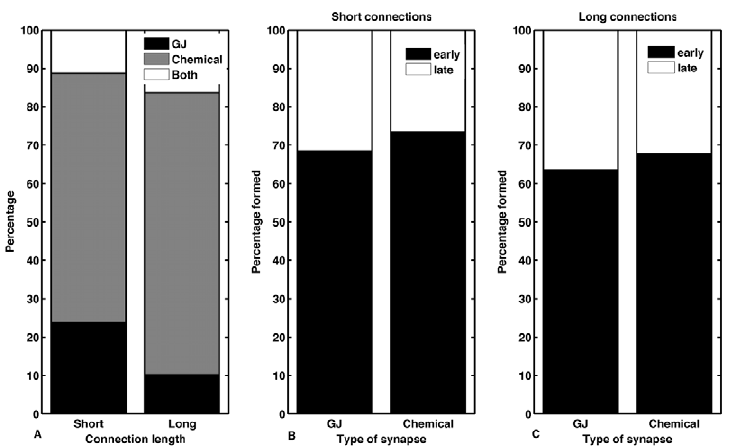
Figure 5. Analysis of gap junctions and chemical synapses in short and long range connections. Approximately a quarter of long- distance and a third of short-distance connections are coupled by gap junctions (including combination junctions). Of these around 70% appear before hatching. (A) Prevalence of gap junctions, chemical synapses and combinations of the two, in short and long distance connections. Appearance of connection-pairs linked by gap junctions and chemical synapses, for short (B) and long-length connections (C). Early and late respectively refer to time periods before and after hatching. (GJ: Gap Junction and Chemical: Chemical synapse)